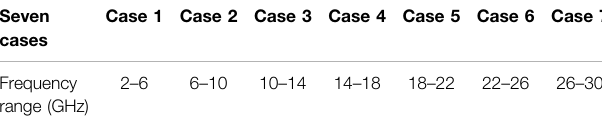
TABLE 4 | Considering seven cases and their corresponding frequency